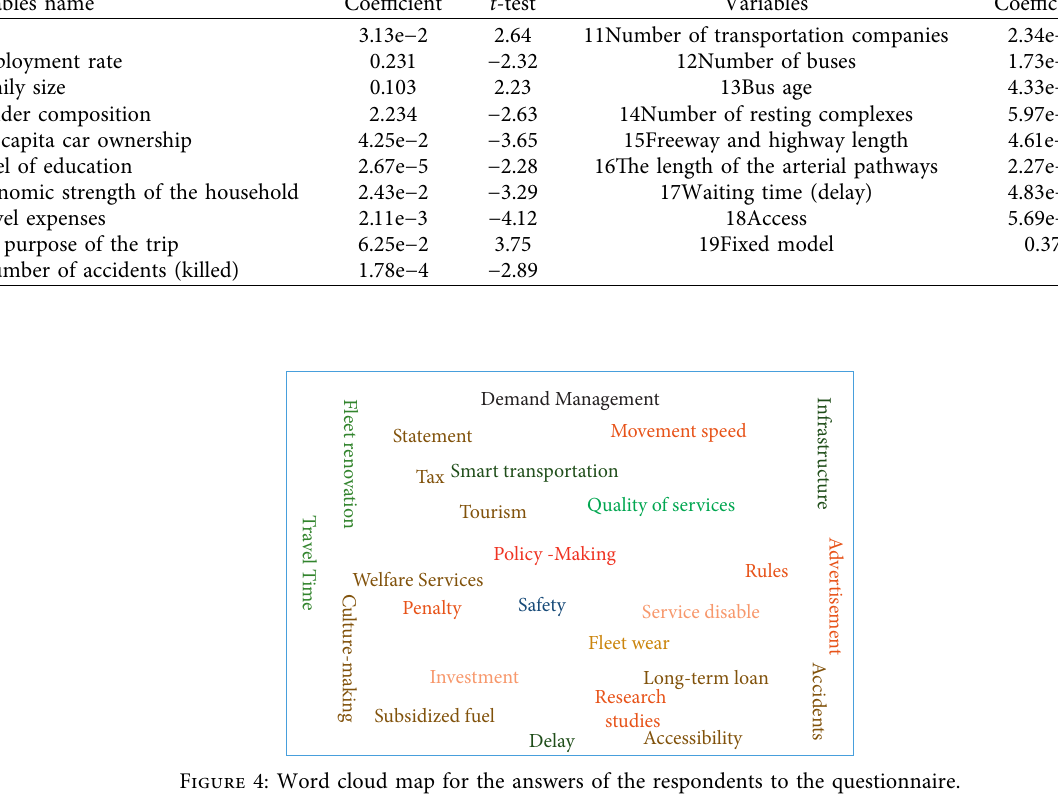
Table 6: Results of constructing the bus passenger estimator model in rural trips. Variables name